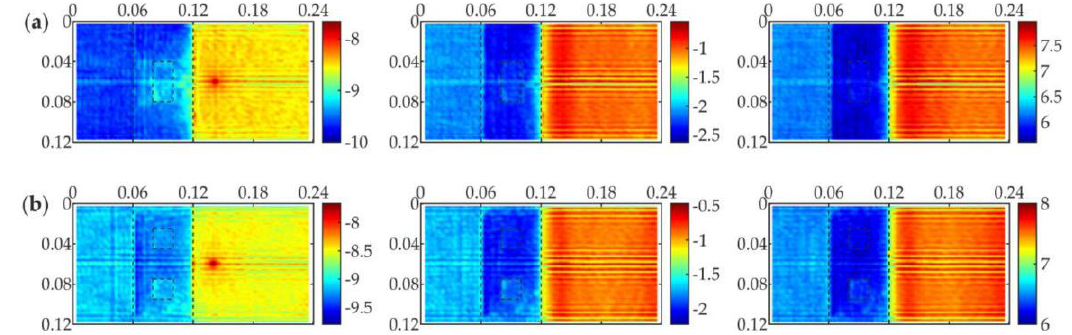
Figure 9. WRMS maps (values in (m/s)) for joints with internal defects for constant time window ( T = 3.00 ms) and different weighting factors w r = 1 (first column), w r = r (second column), w r = r 2 (third column): ( a ) specimen #8; and, ( b ) specimen #9.